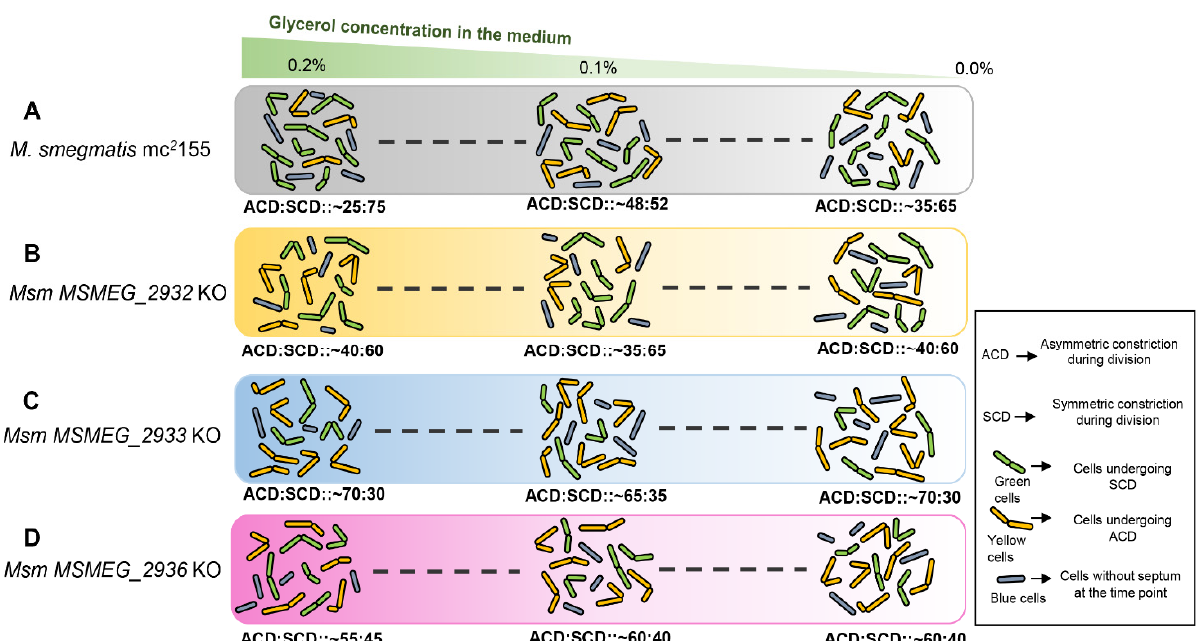
Figure 8. Model for the change in the ACD:SCD proportions in M. smegmatis cultures in response to glycerol levels in the growth medium. The ACD:SCD proportions are compared at 0.2% (initial), 0.1%, and almost nil at onset of stationary phase. The ACD:SCD proportions are shown for: ( A ) M. smegmatis mc 2 155, where the proportion changed from low-ACD/high-SCD to ~50:50 of ACD:SCD at 0.1% and again to low-ACD/high-SCD upon further decrease in glycerol levels; ( B ) Msm MSMEG_2932 KO always showed low-ACD:high-SCD even at 0.1% glycerol concentration; ( C ) Msm MSMEG_2933 KO; and ( D ) Msm MSMEG_2936 KO strains always showed high-ACD:low-SCD proportion despite change in glycerol levels. Thus, Msm , with the loss of one of these genes, lost the ability to change ACD:SCD proportions in response to glycerol levels.